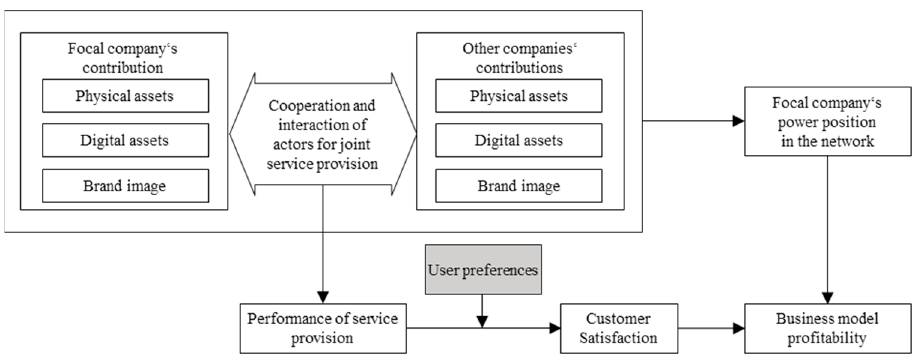
Figure 6. Conceptual framework (own figure).